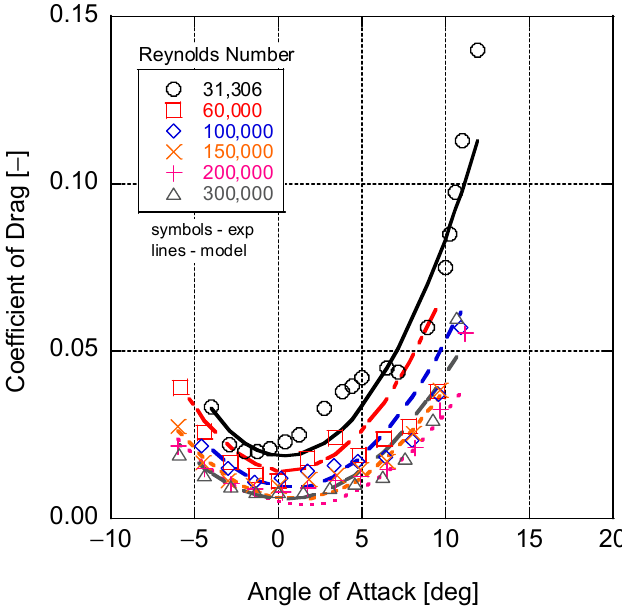
Figure 8. Experimental and model C d values as functions of Re numbers and AoA.